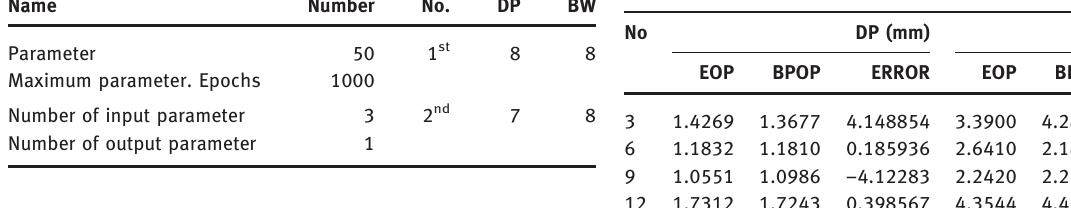
Table 7: BPNN parameters and interlayer details.